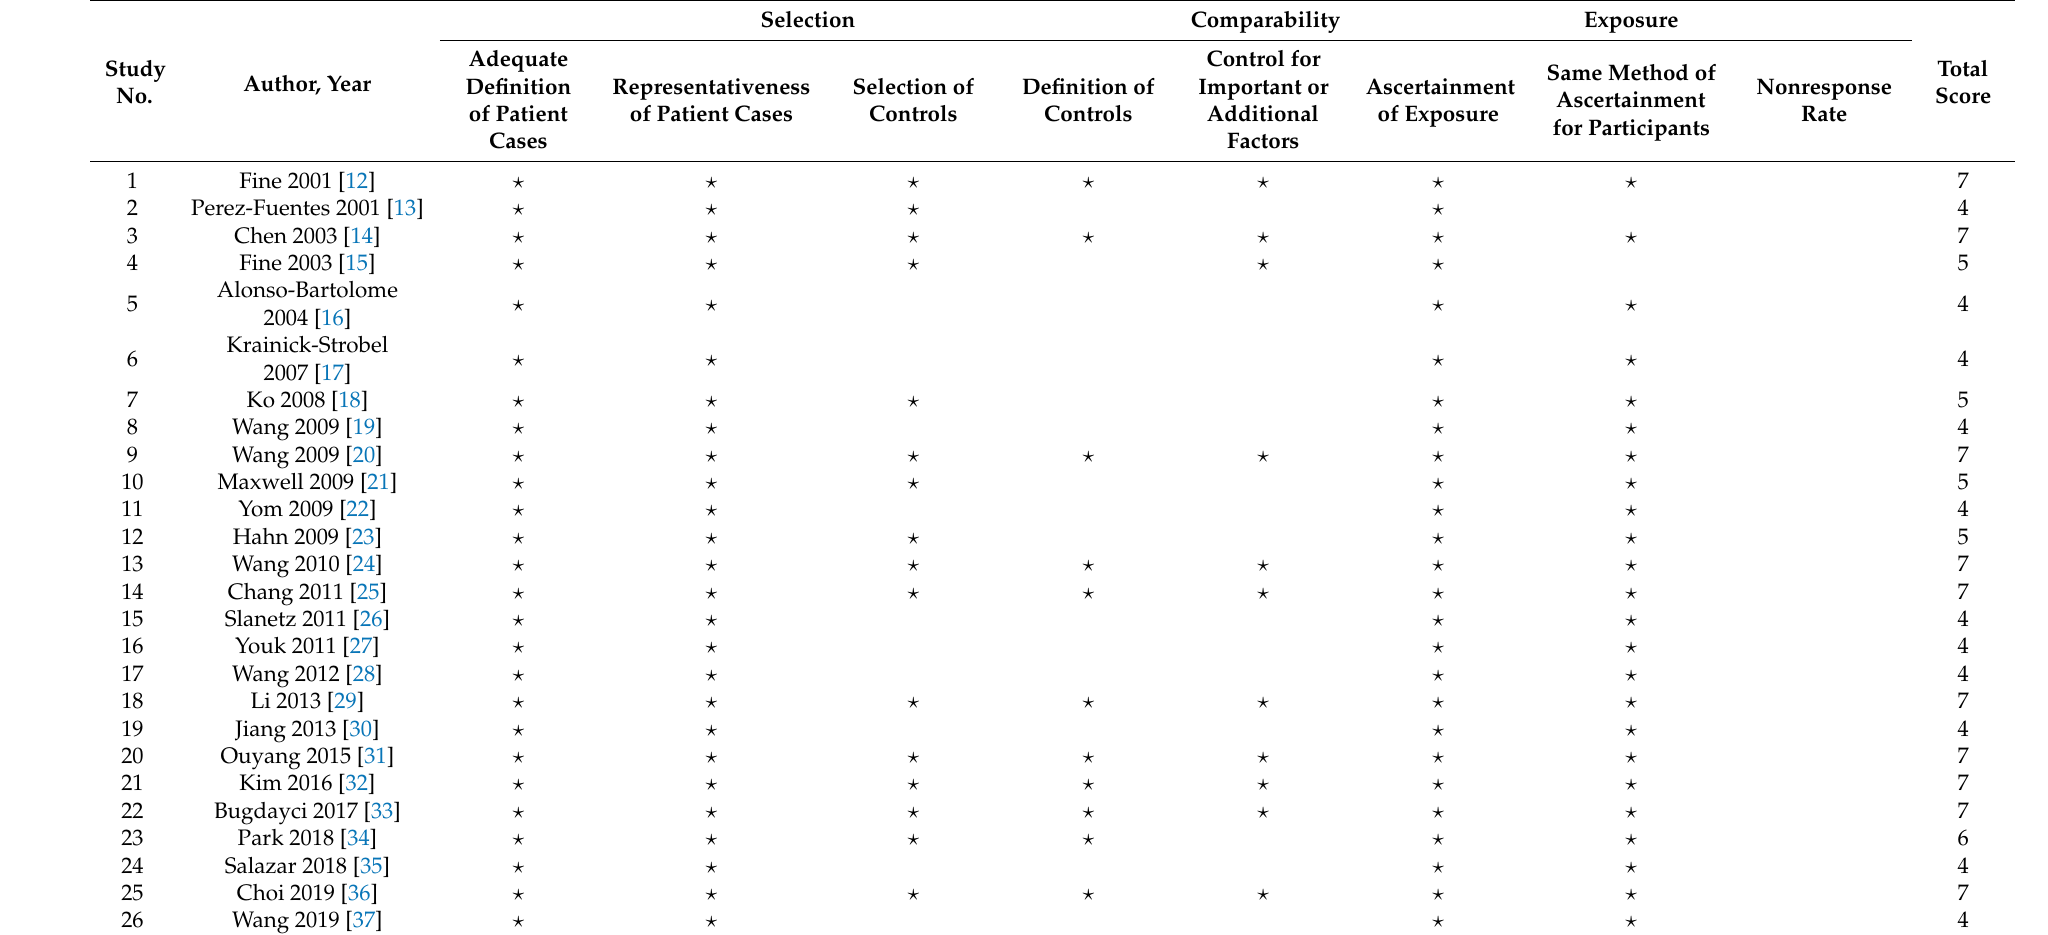
Table 2. NOS for the risk of bias and quality assessment of